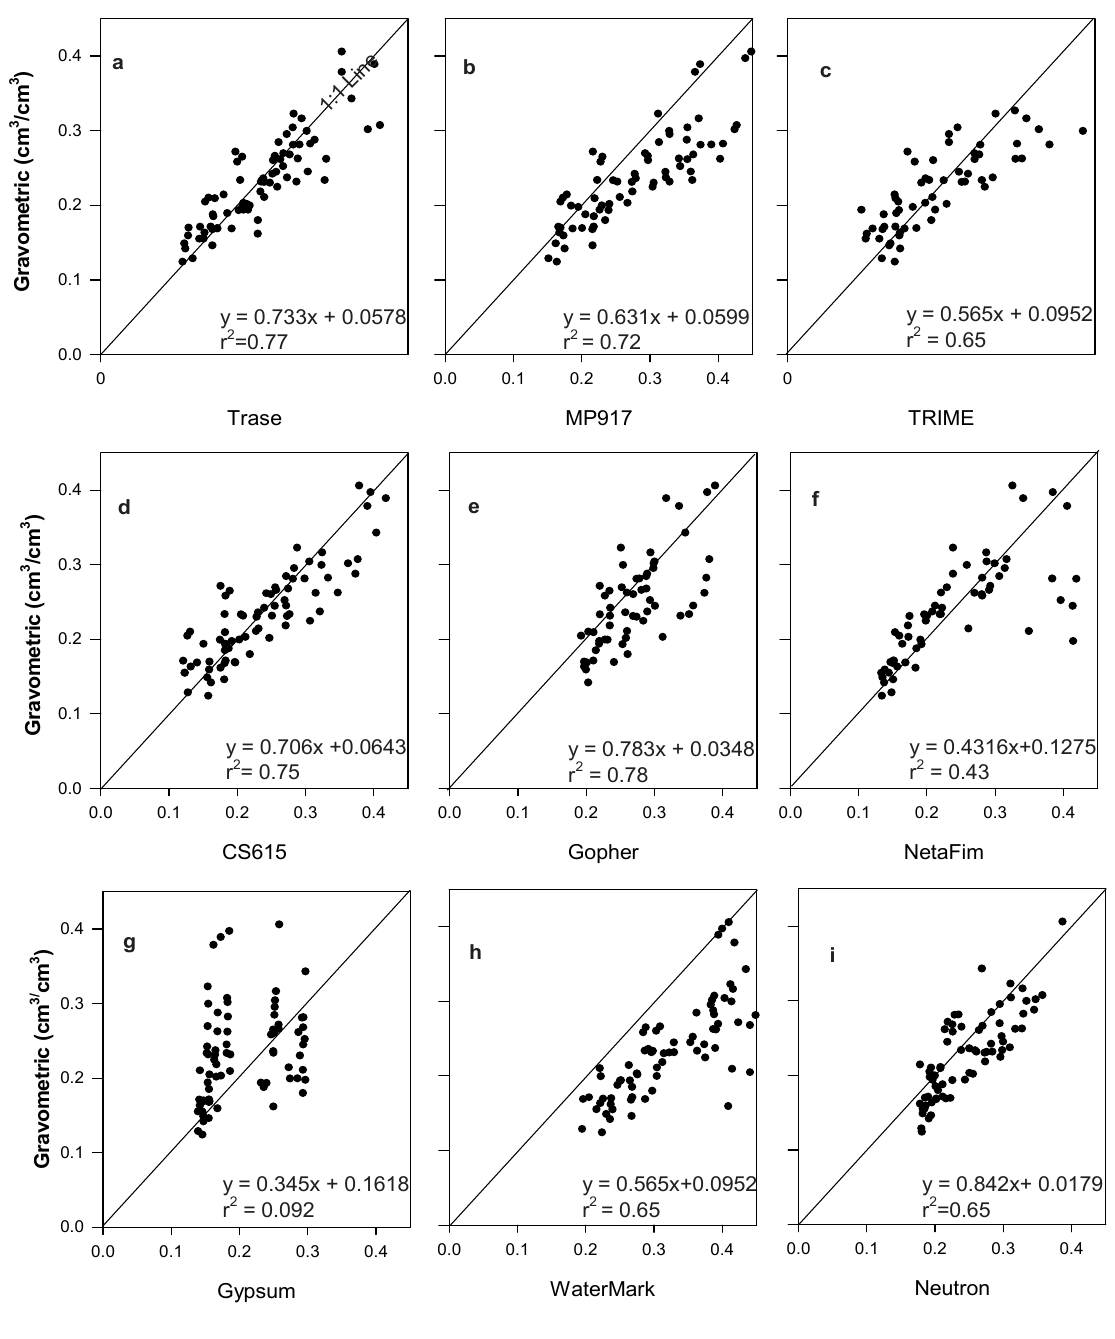
Figure 3. Regression relationship between gravimetric measurements (Y axis) of soil water and measurements obtained through different sensors (X axis). (The p- values of the regression between GM and each sensor measurement were <0.0001 except for Gypsum (0.008) and WaterMark